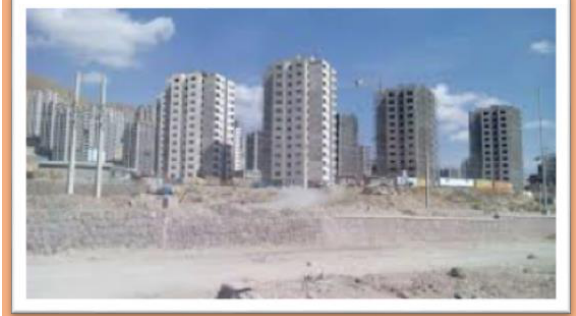
Figure 5 : Pardis Mehr housing in suburbs area (URL 4).